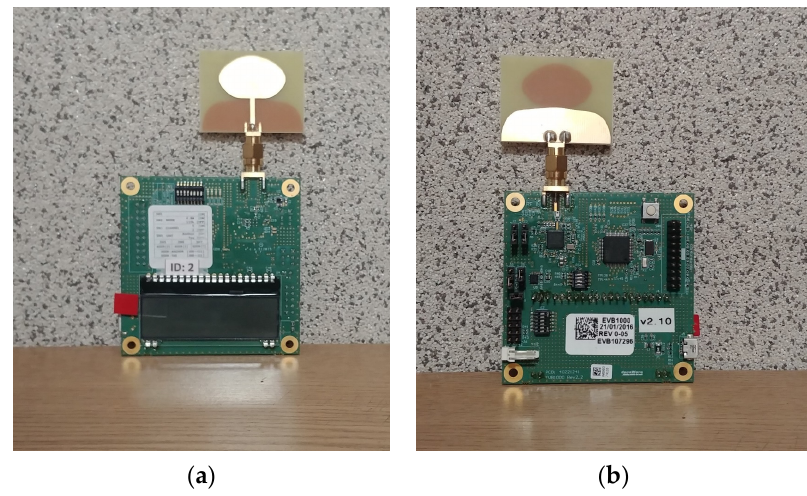
Sensors 2020 , 20 , x FOR PEER REVIEW Figure 1. TREK1000 module: ( a ) front view and ( b ) rear view. Figure 1. TREK1000 module: ( a ) front view and ( b ) rear view.